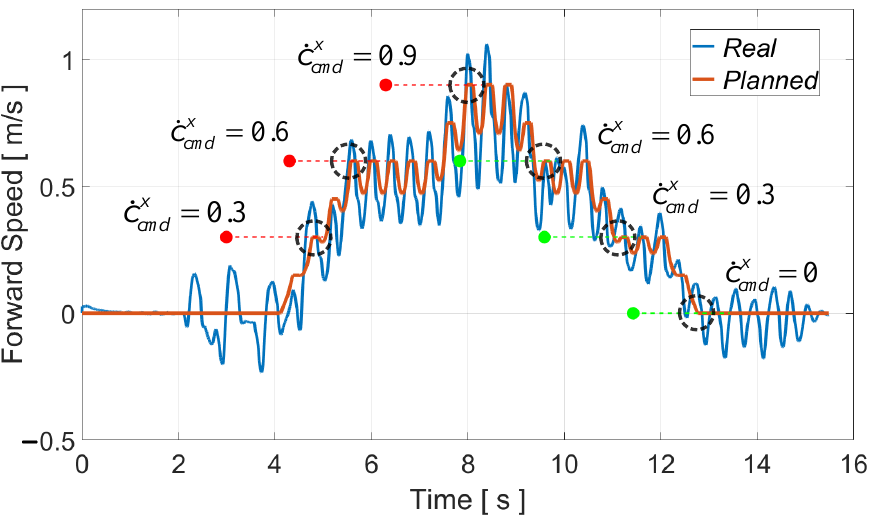
Figure 7. Real and planned forward speed during